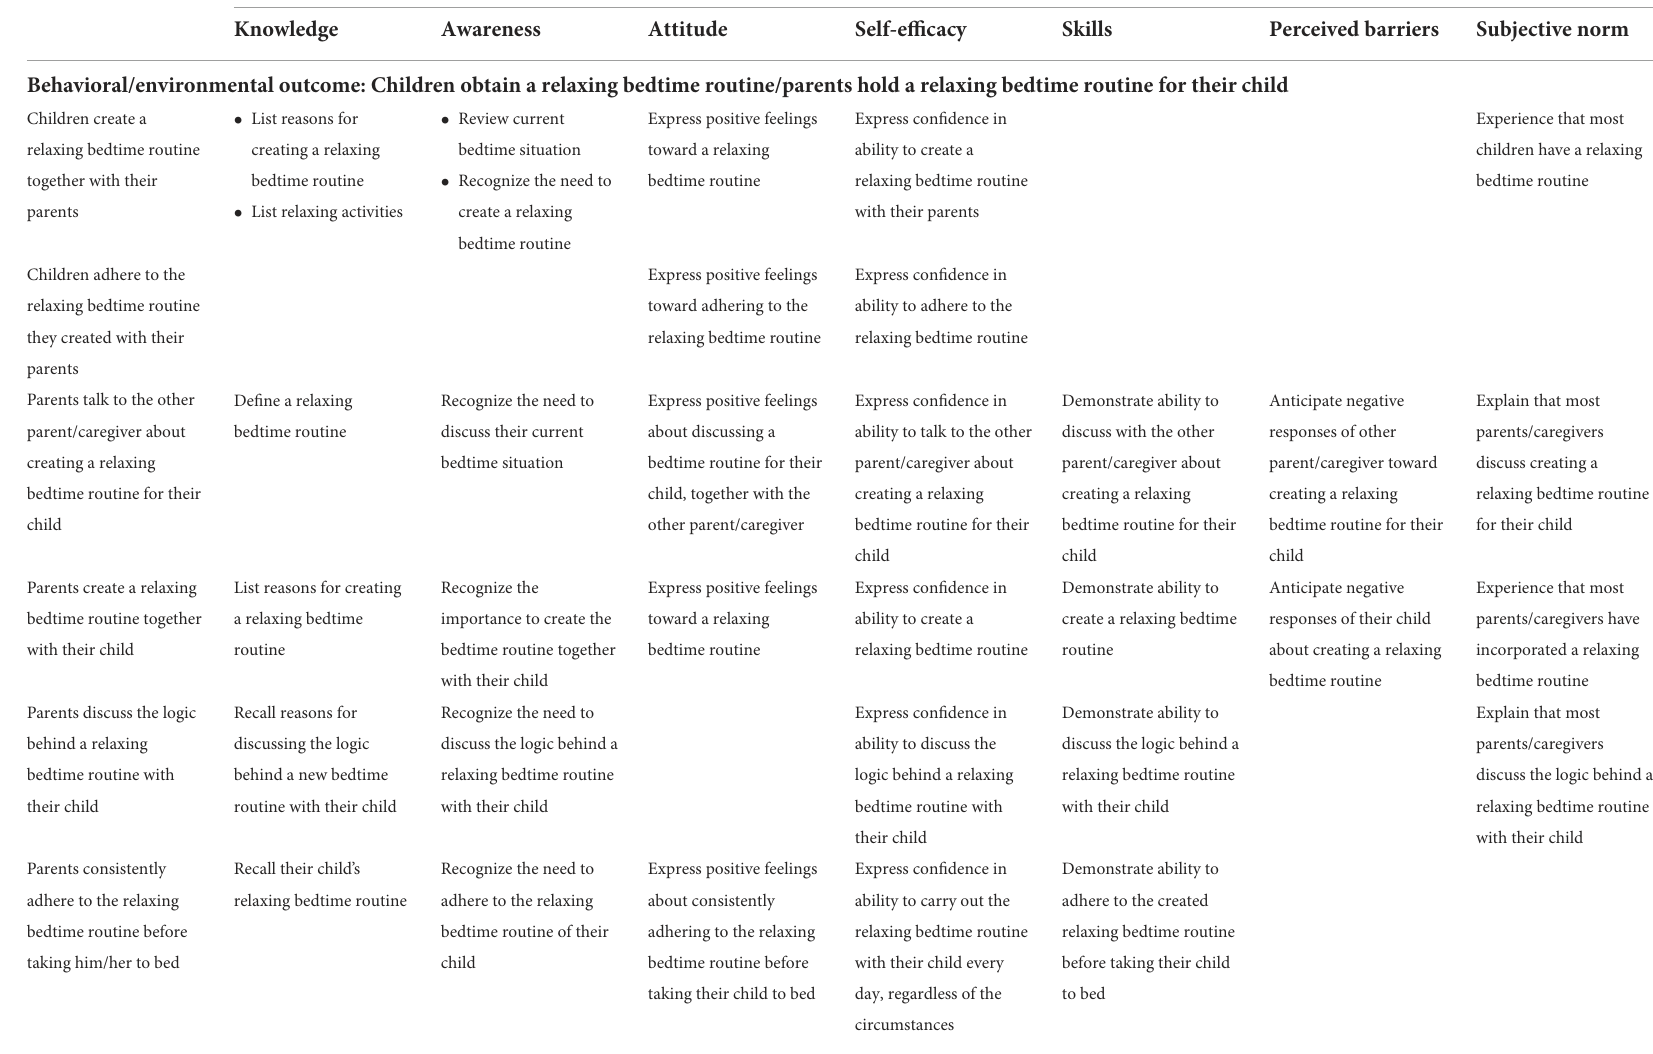
TABLE 1 Examples of performance and change objectives for children and